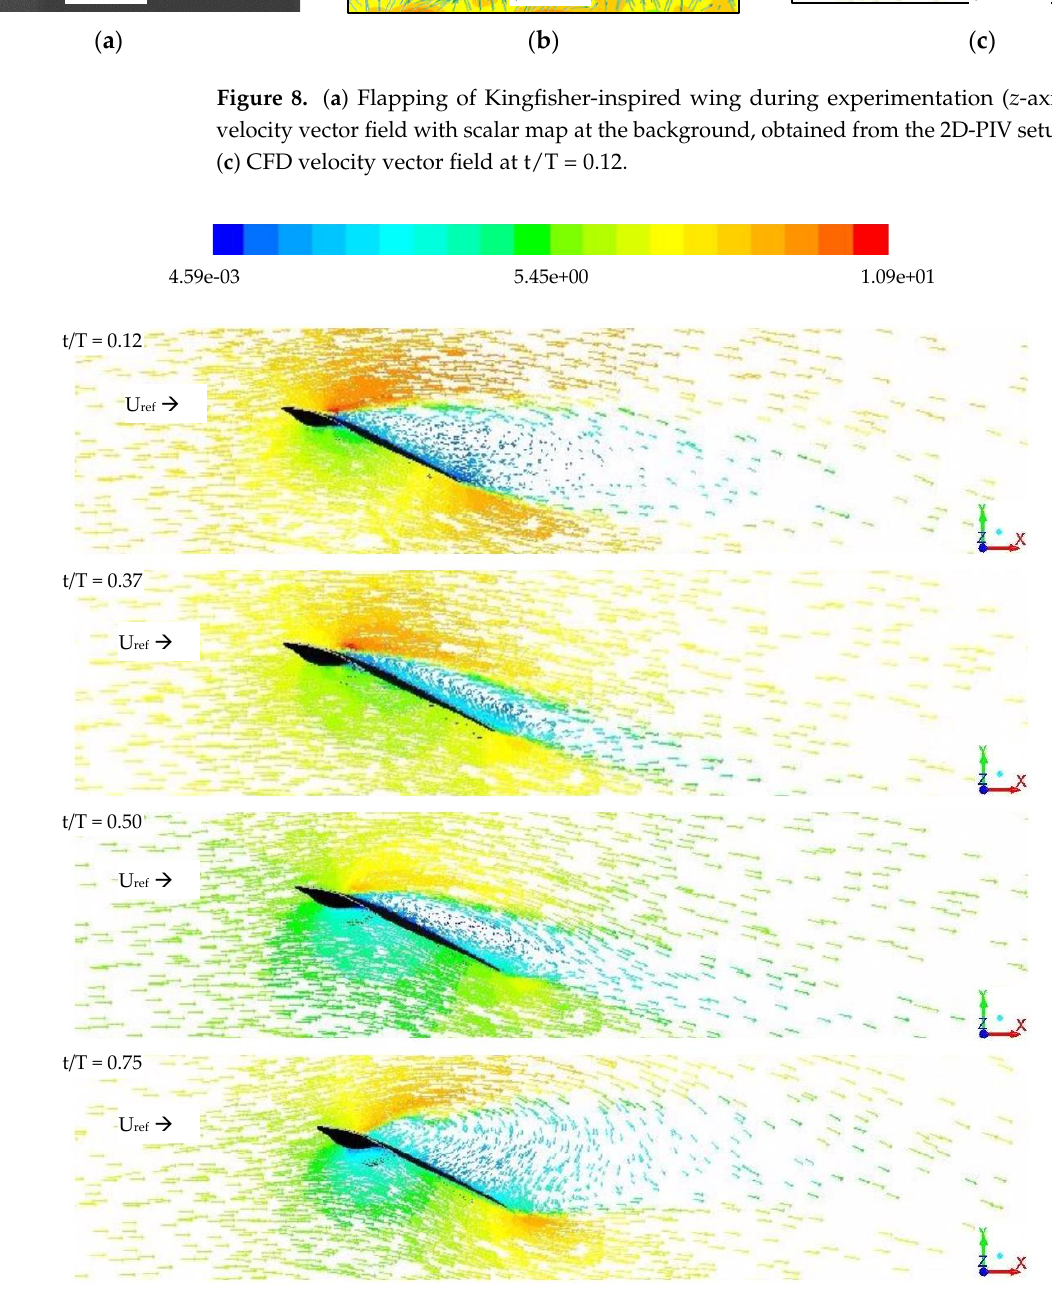
t/T = 0.12 t/T = 0.12 t/T = 0.12